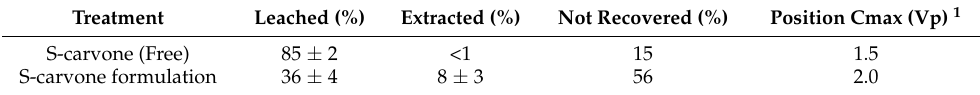
Table 2. Data derived from the relative and cumulative breakthrough curves in the leaching experiment. Treatment